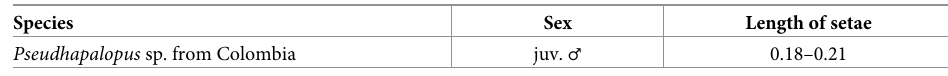
Table 8. Length ranges of subtype I f setae. juv. = juvenile